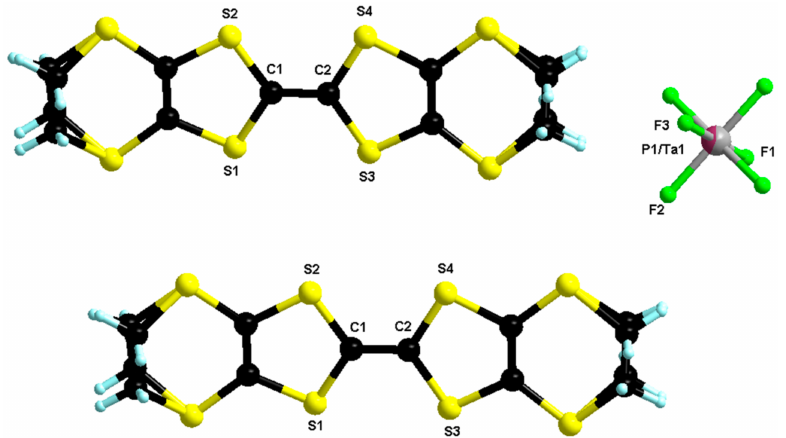
Figure 4. Molecular structure of δ o -(BEDT-TTF) 2 (TaF 6 ) 0.43 (PF 6 ) 0.57 . The two carbon atoms of both ethylene parts were disordered over two positions with refined partial occupancy factors 0.73/0.26 and 0.62/0.38.